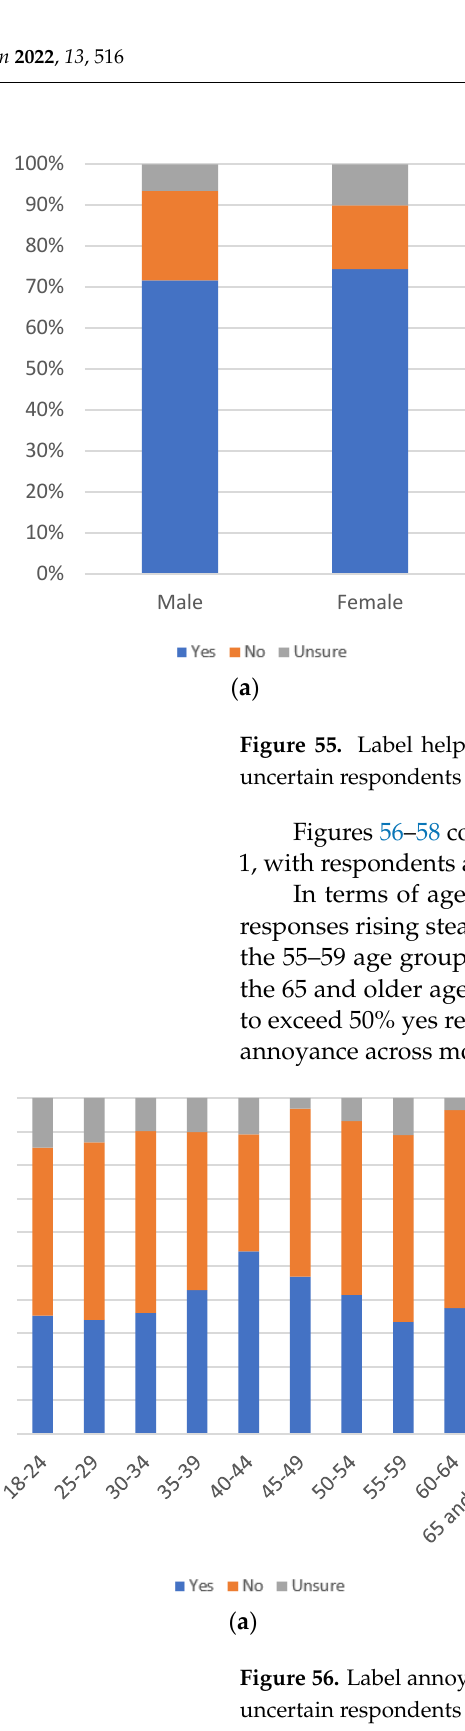
( b ) Figure 57. Label annoyingness, by education level: ( a ) with uncertain respondents (left) and ( b ) without uncertain respondents (right).